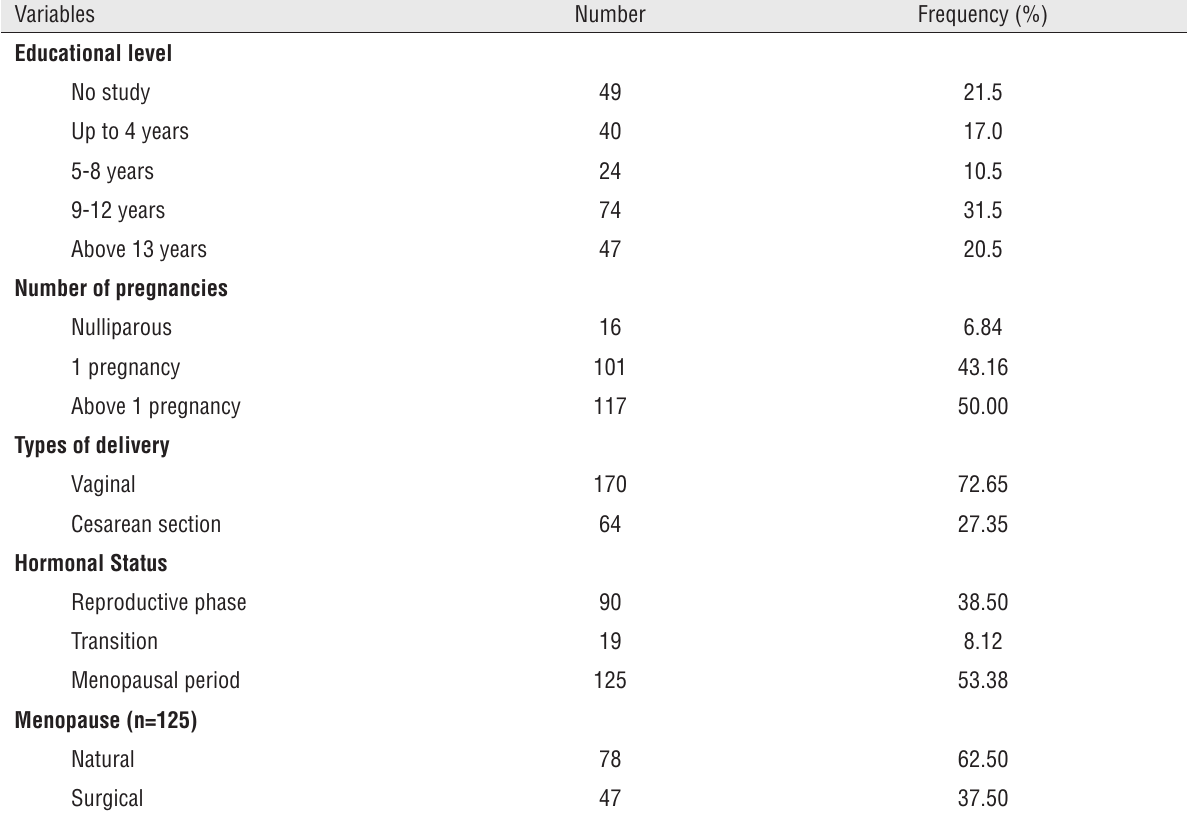
Table 1 - Characteristics of the volunteers